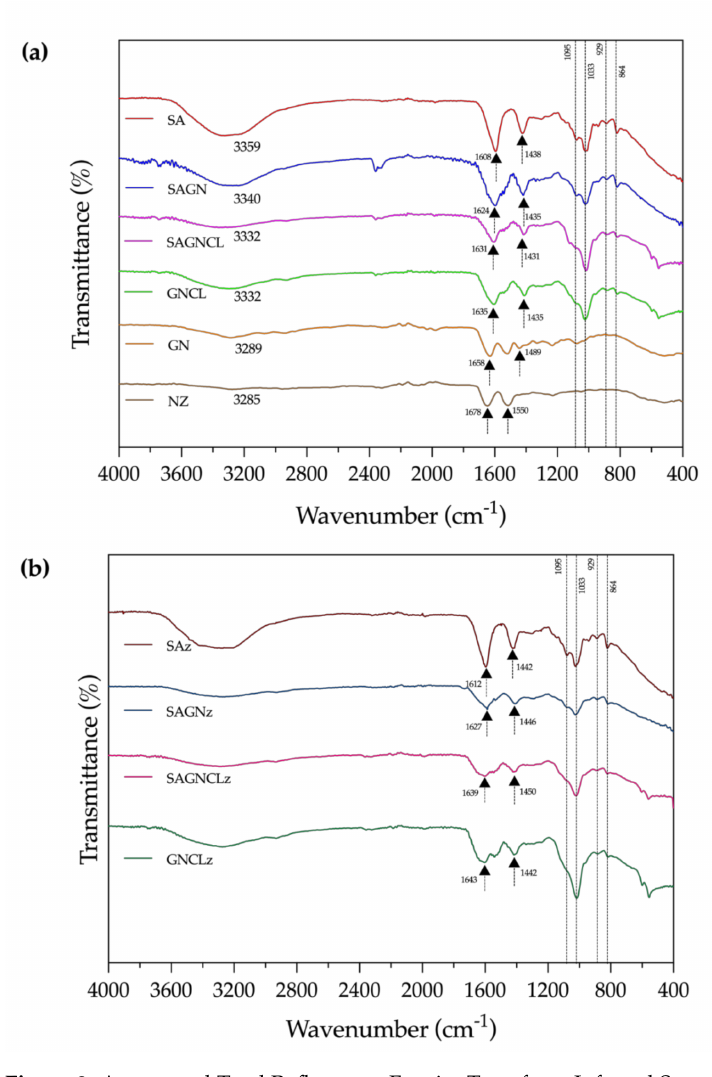
Figure 3. Attenuated Total Reflectance-Fourier Transform Infrared Spectroscopy (ATR-FTIR) spectra of ( a ) SA, SAGN, SAGNCL, GNCL microfibers, GN and Nizin Z powder and ( b ) SAz, SAGNz, SAGNCLz and GNCLz